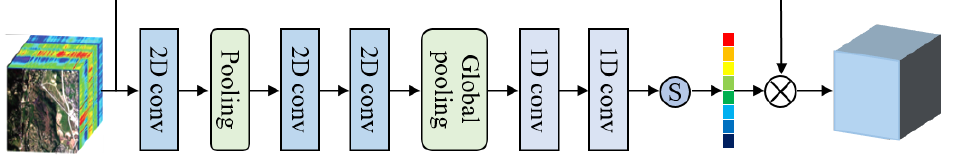
Figure 4. The schematic of the structure of BAM. S and (cid:78) denote the sigmoid activation function and the multiplication of elements,